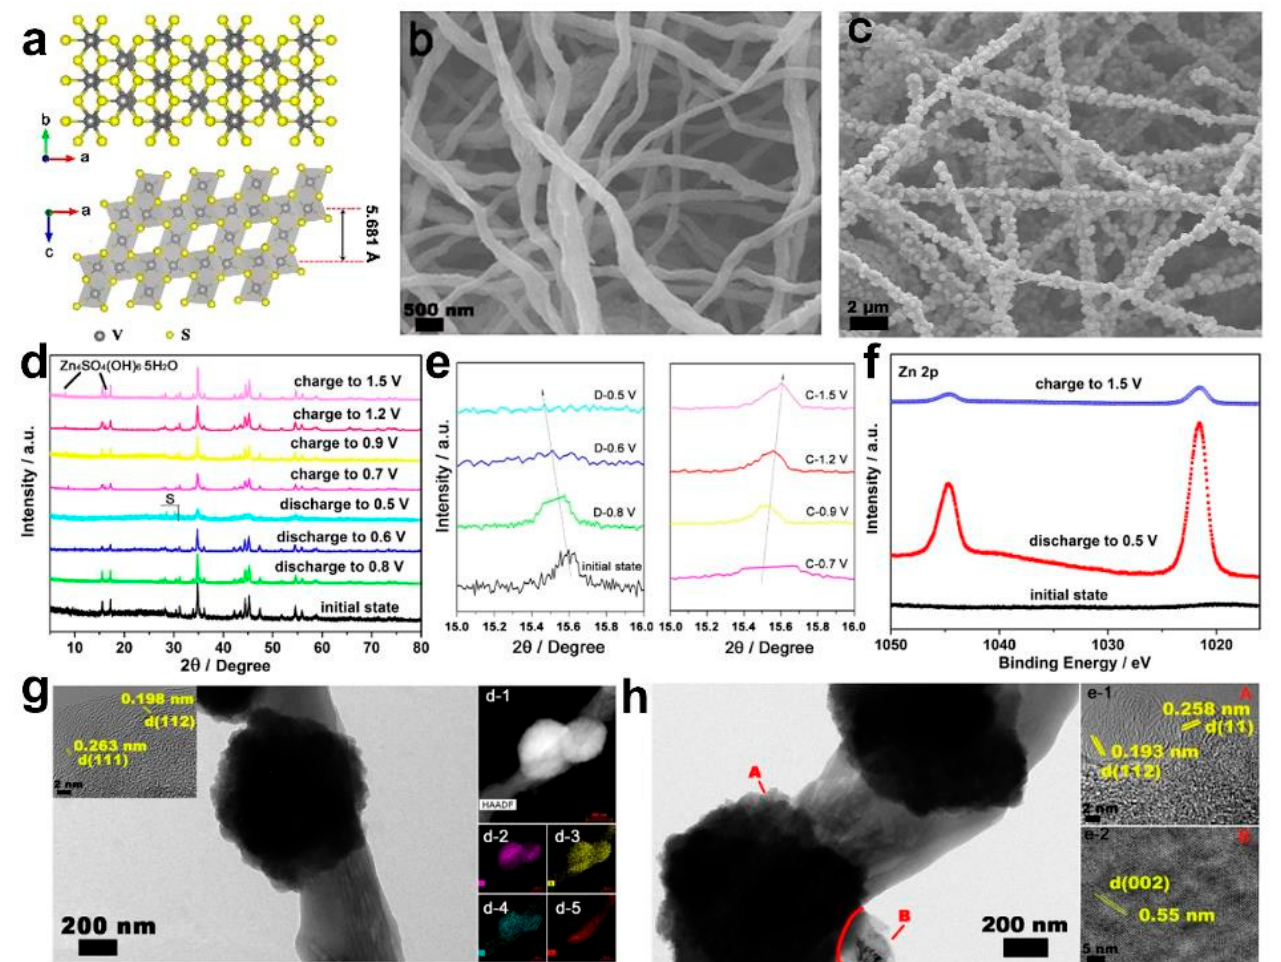
Figure 7. ( a ) Schematic diagram of the V 3 S 4 [78]. ( b ) The SEM images of the HCC and ( c ) the HCC- V 3 S 4 [78]. Ex situ ( d , e ) XRD patterns of HCC-V 3 S 4 and ( f ) XPS spectra of HCC-V 3 S 4 . [78]. ( g ) TEM